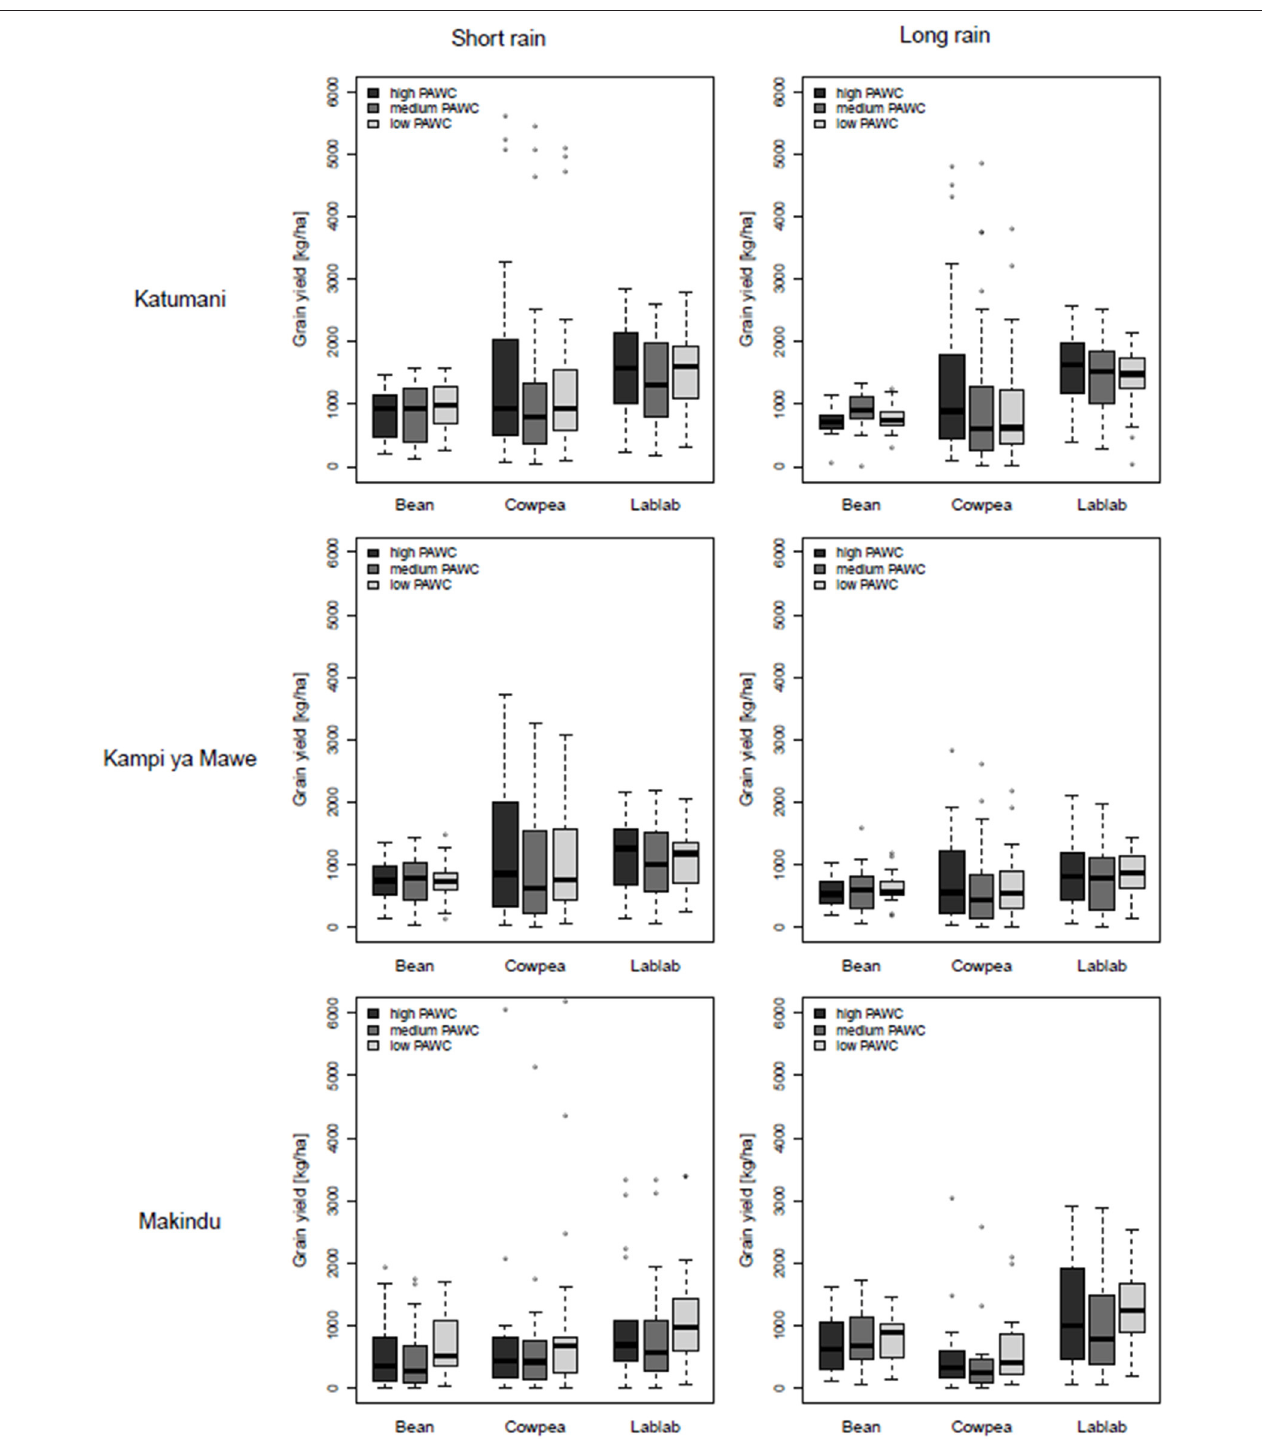
FIGURE 4 | Boxplots of simulated grain yields for common bean, cowpea, and lablab at different rainfall zones (Katumani, Kampi ya Mawe, and Makindu, Eastern Kenya) grown during the growing period of the short rain and the long rain on soils with different plant available water capacity (PAWC, high, medium, and low) based on results from the long-term simulation.